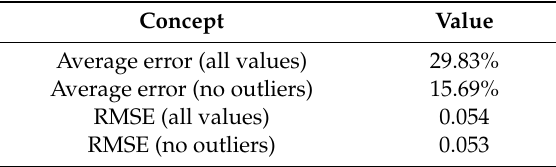
Table 4. Error values for the calculated distances.